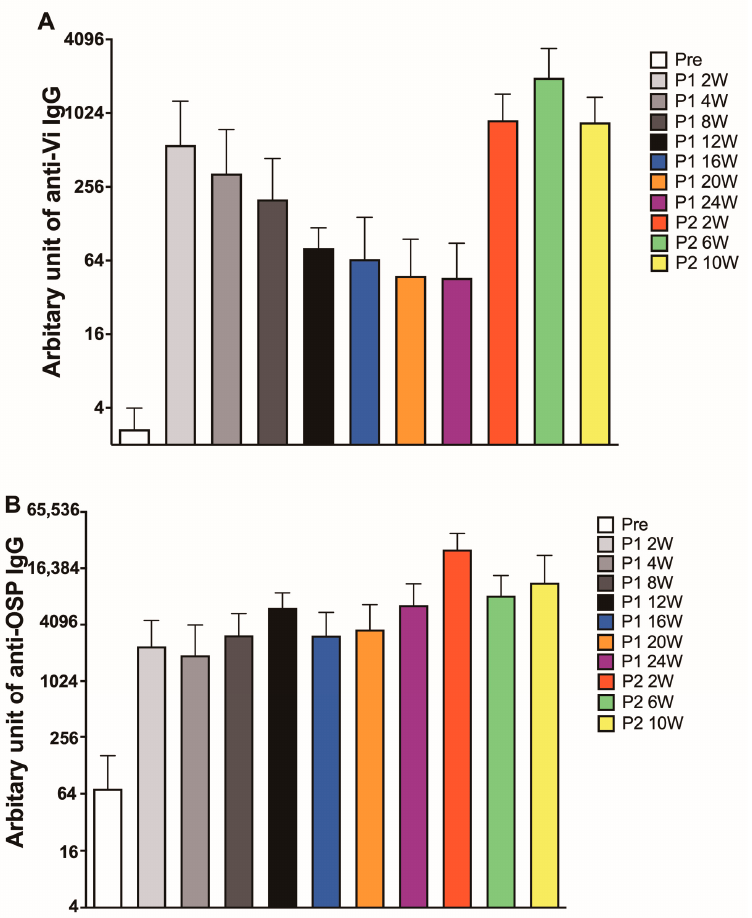
Figure 5. IgG kinetics in rabbits that received one or two immunizations of the bivalent vaccine. ( A ). Anti-Vi IgG titer kinetics. ( B ). Anti-OSP IgG titer kinetics. Each group contained ten rabbits. Bars showed geometric mean antibody titers and 95% confidence intervals.